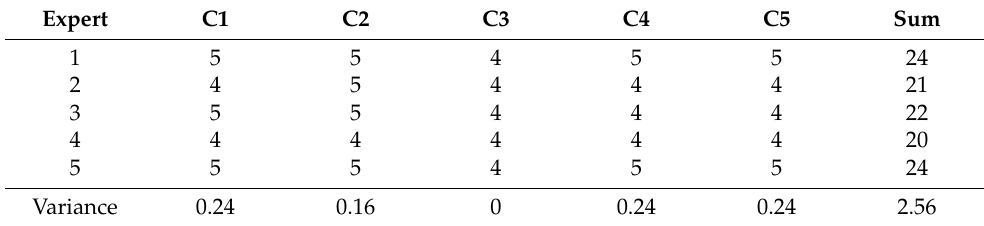
Table 6. Results for internal consistency of diagnostic and knowledge tests with experts. Expert